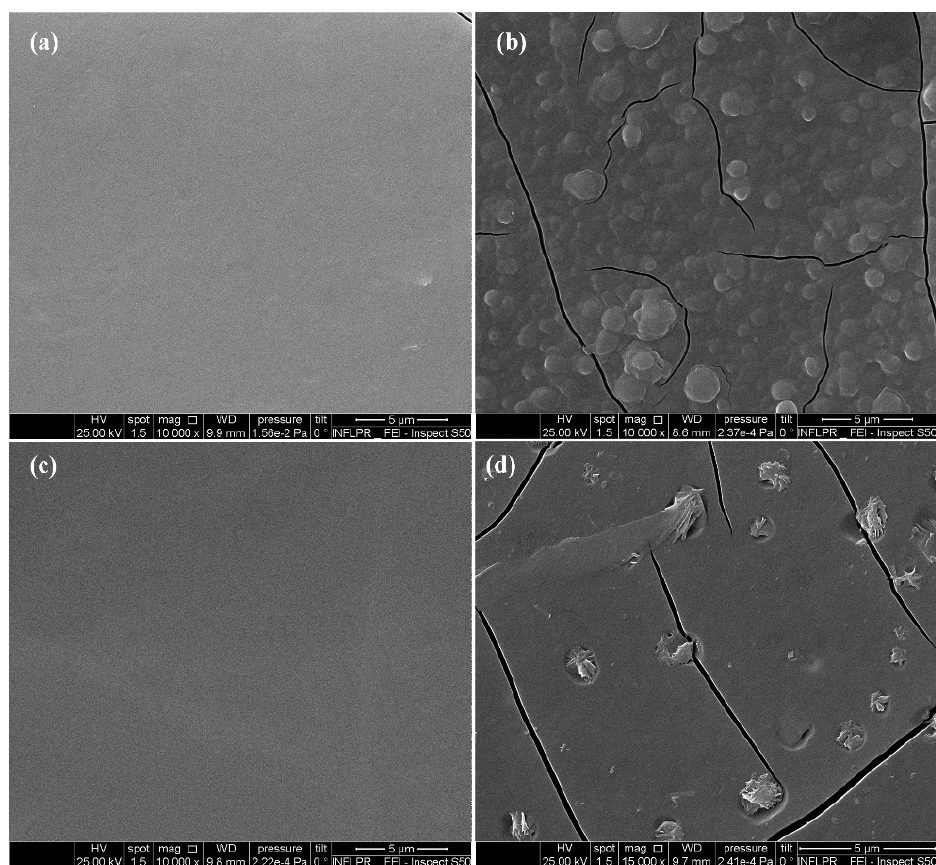
Figure 6. SEM images of thin films deposited at 200 mJ/cm 2 for ( a ) PVP/FL, ( b ) CF/PVP/FL, ( c ) PVP/FW, and ( d ) CEFTRI/PVP/FW.